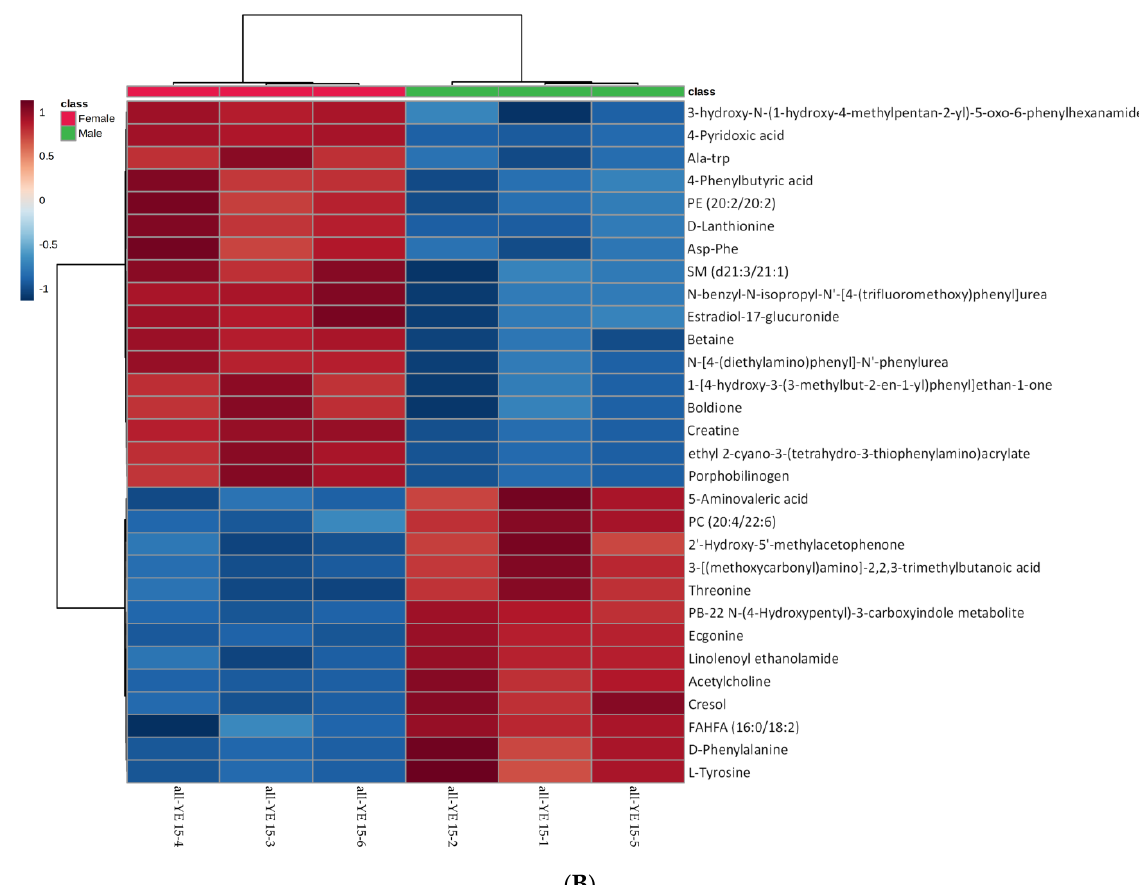
Figure 4. Differential yolk metabolites identified from male and female chicken embryos at E15 ( n = 3). ( A ) The volcano plot shows the combination of the fold changes and the p values of each metabolite. The red dots represent the metabolites that were significantly upregulated in female birds, while the blue dots represent the metabolites that were significantly downregulated in female birds. ( B ) Heatmap showing the difference profile of yolk metabolites between male and female chicken embryos. Each cell in the plot corresponds to a normalized z-score value. Sample names are in columns and compound names are in rows.